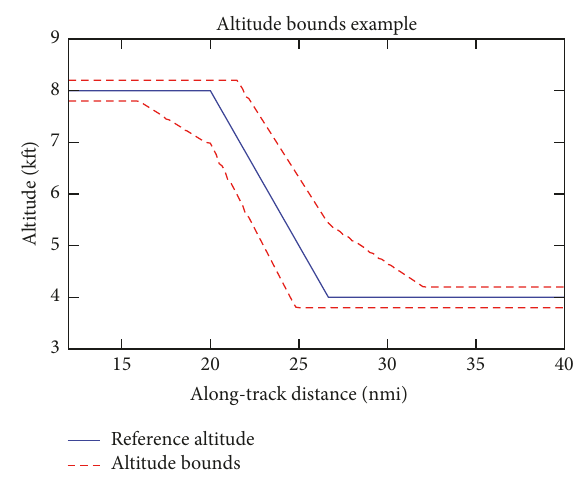
Figure 3: Simplified example of altitude bounds as a function of distance along route